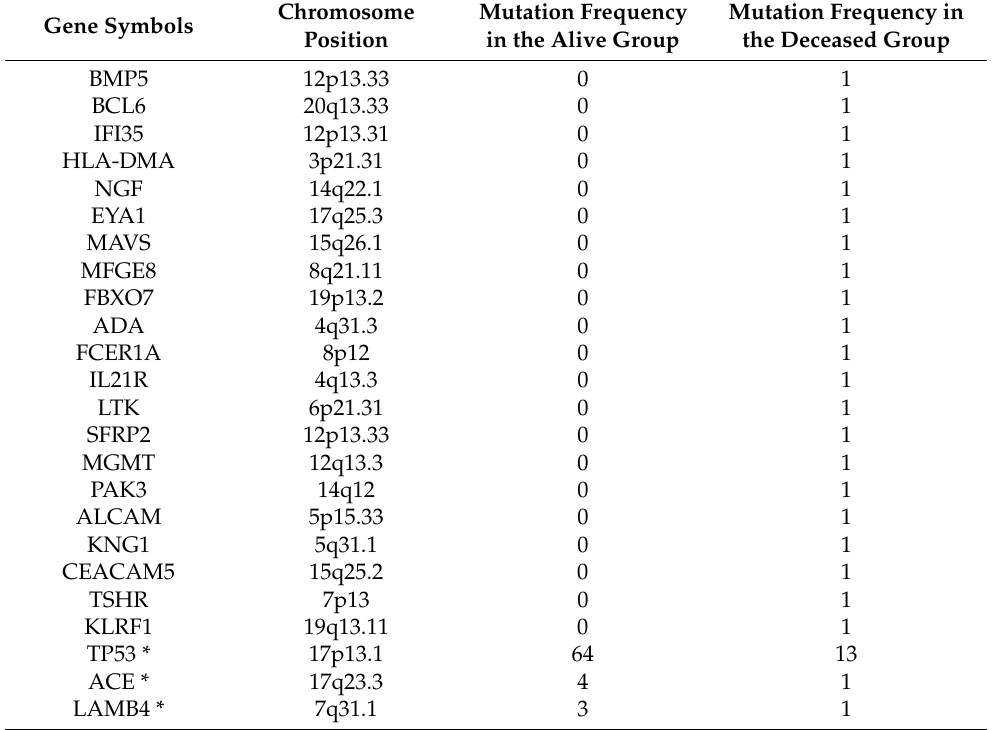
Table 4. Somatic mutated immune-modulated genes associated with TNBC in the deceasedde- ceased group.